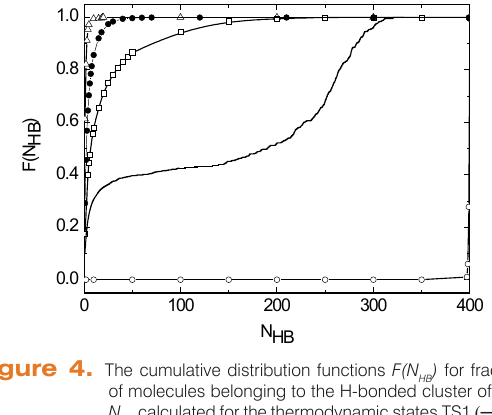
Figure 4. The cumulative distribution functions F(N of molecules belonging to the H-bonded cluster of size N calculated for the thermodynamic states TS1 (─○─) , HB TS2 (–––) , TS3 (─□─) , TS4 (─●─) , TS5 (─∆─) .